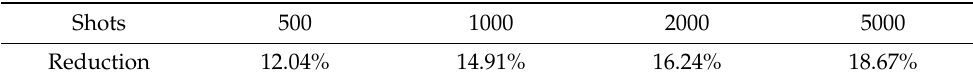
Figure 13. Surface state of ( a ) electrodes contacted area and ( b ) flashover channel area. In addition, the flashover voltage was tested after 500, 1000, 2000 and 5000 shots, and the reduction from the initial state is shown in Table 2. Table 2. Reduction of flashover voltage during the aging process.